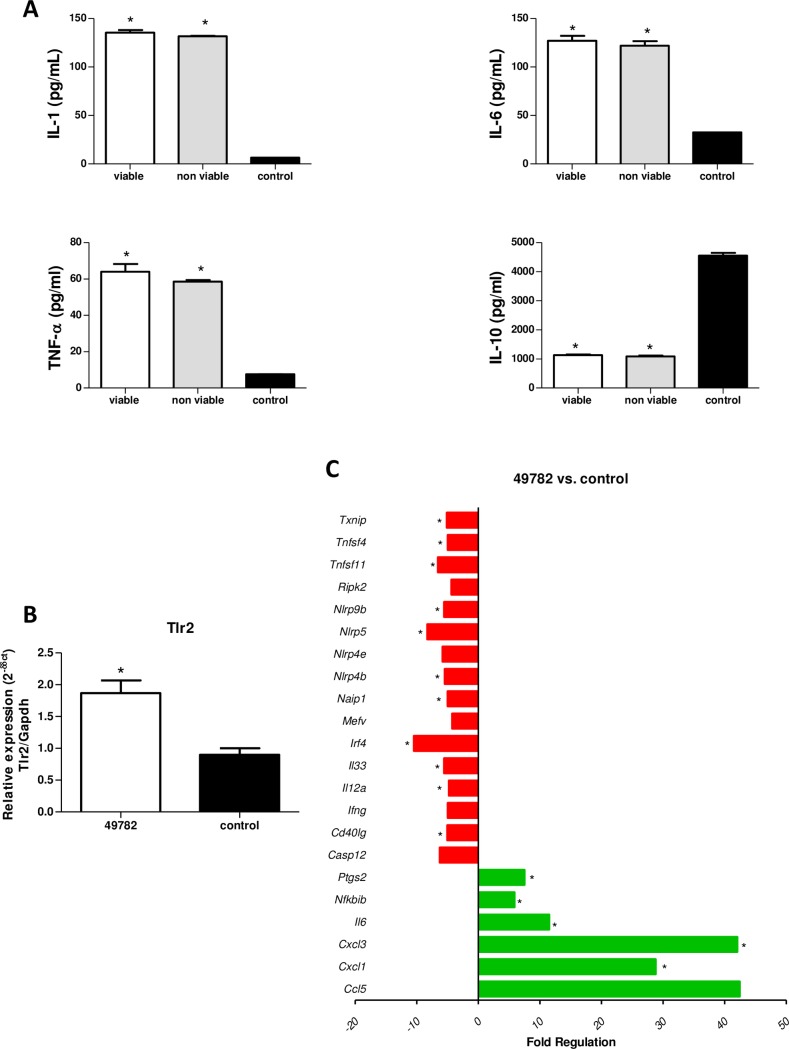
Host immune response against surface molecules.(A) IL-1β, IL-6, TNF-α and IL-10 levels in supernatant of macrophage J774 culture after infection with viable and nonviable U. diversum ATCC 49782 strain compared to uninfected cells. Statistical significance (p<0.05) is represented by the asterisk (*) (non-parametric Mann-Whitney analysis—One-tailed test, GraphPad Prism® version 6.01). (B) Gene expression of Toll-like receptors 2 in macrophage J774 culture after infection with U. diversum ATCC 49782 strain compared to the uninfected cells. Statistical significance (p<0.05) is represented by the asterisk (*) (non-parametric Mann-Whitney analysis—One-tailed test, GraphPad Prism® version 6.01). (C) up-regulated (green) and down-regulated genes (red) of the inflammasome pathways in macrophage J774 culture after infection with U. diversum ATCC 49782 strain compared to uninfected cells. Statistical significance (p<0.05) is represented by the asterisk (*) (non-parametric Mann-Whitney analysis—One-tailed test, GraphPad Prism® version 6.01).